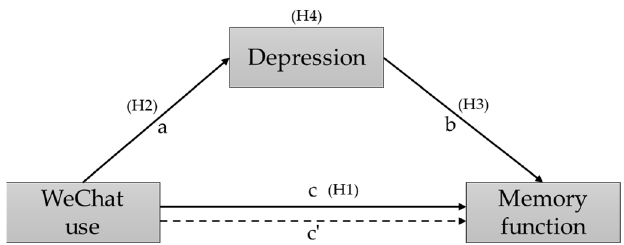
Figure 1. The hypothesized model concerning the relationships between WeChat use, depression, and memory performance.